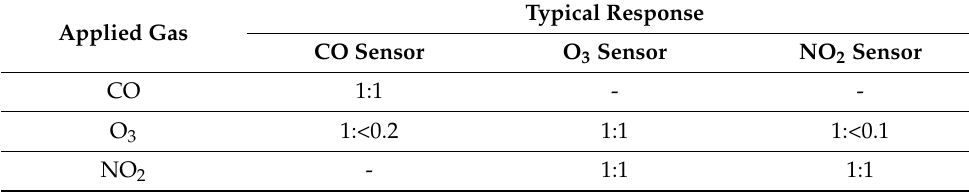
Table 2. Cross sensitivity of each sensor [37].